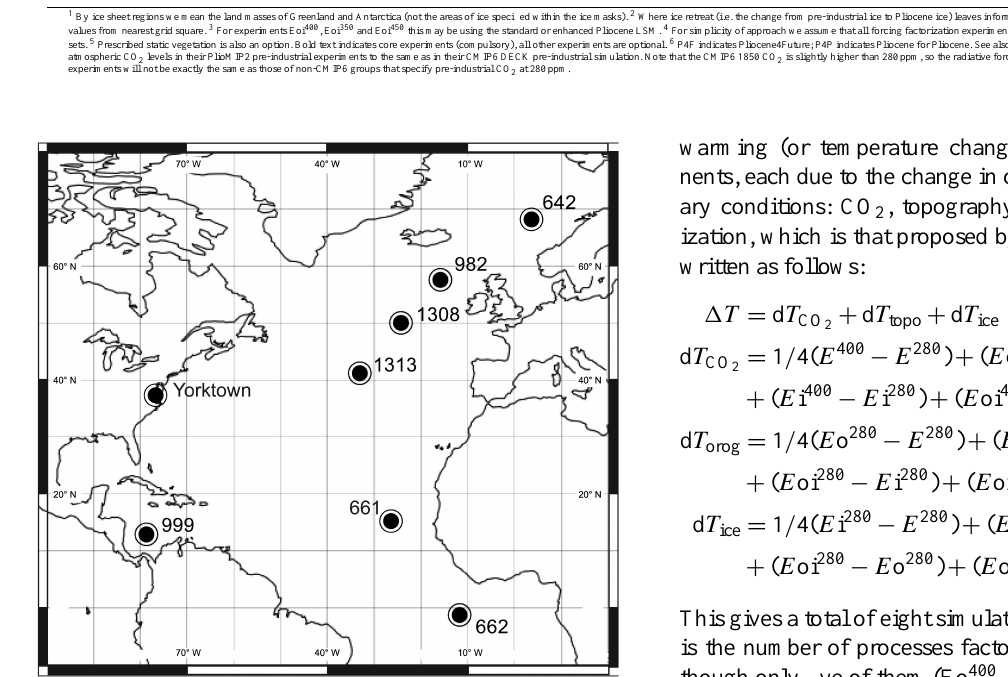
Figure 7. Initial PRISM4 sites being investigated to generate time slice proxy data for model evaluation in PlioMIP Phase